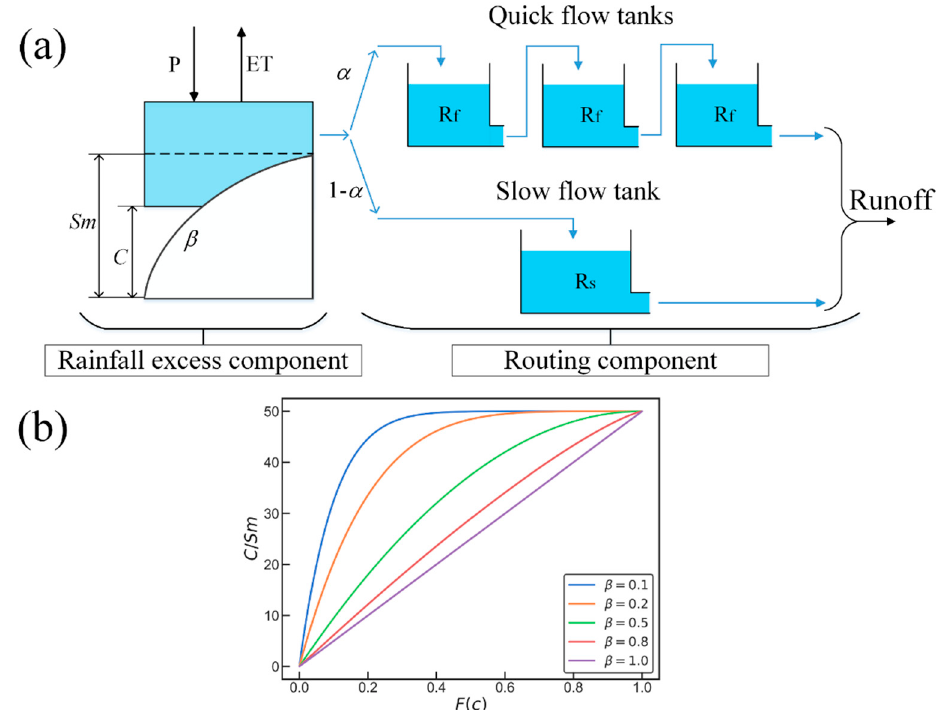
Figure 3. ( a ) Schematic illustration of the Hymod model. ( b ) Distributions of the soil moisture storage capacity of a given catchment, while the parameter β changes from 0.1 to 1.0 based on Equation (1).